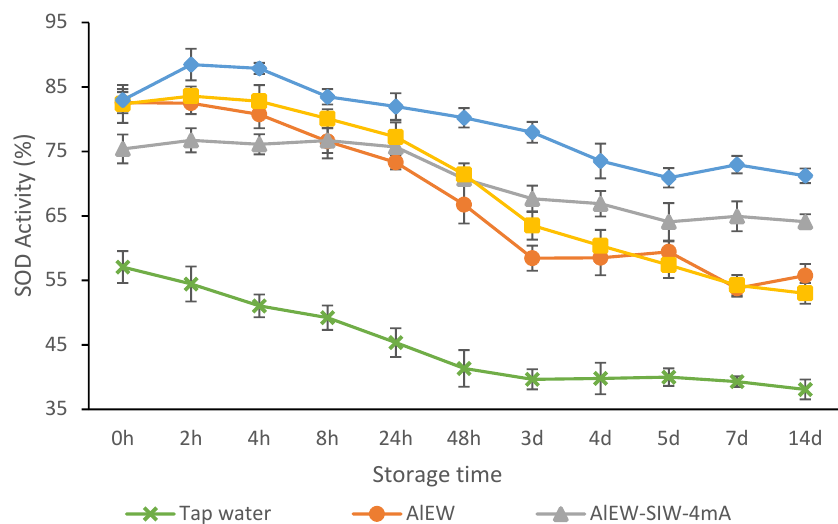
Figure 4. The effect of storage time on the antioxidant activity of each sample solution. AlEW, alkaline electrolyzed water; TMW, tourmaline water; AlEW/TMW-SIW-4mA, silver-ionized water produced by using AlEW or TMW as electrolyte at 4 mA; Tap water was used as control. Each value is expressed as the mean value ± standard deviation of three replicates. All sample solutions in this study contained 2 mmol/L AsA.